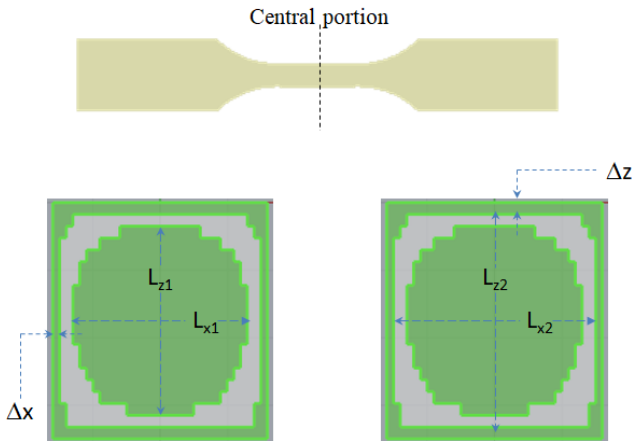
Figure 7. The definition of the dimensions of the core and skin in the cross section of the central portion of the specimen.